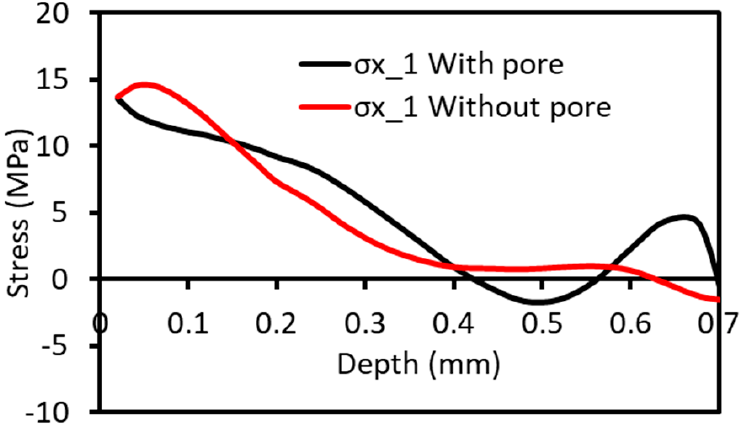
Figure 12. Residual stress profiles for the material being free of pores and featuring